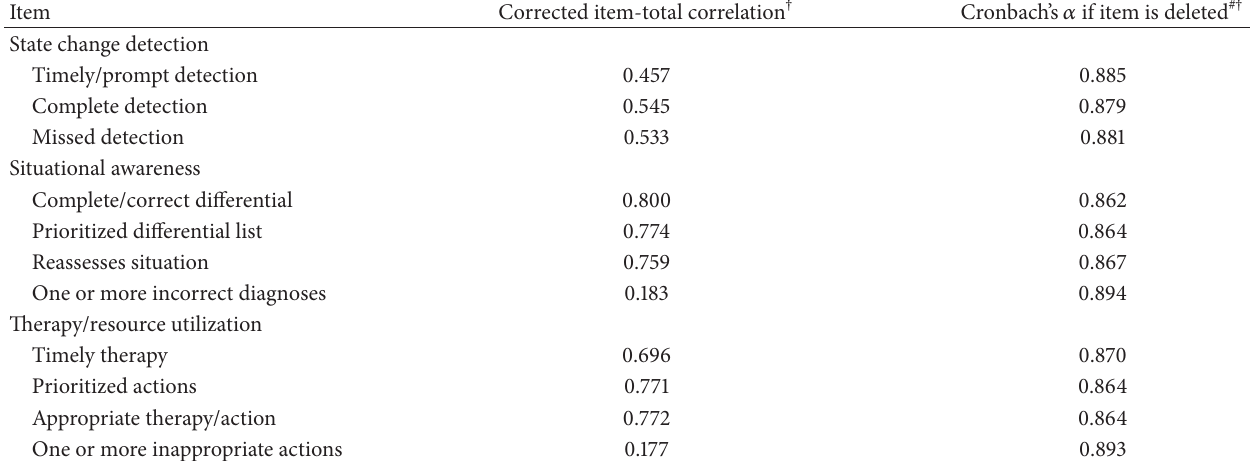
Table 2: Internal consistency of Crisis Management Checklist considering all emergency scenarios.